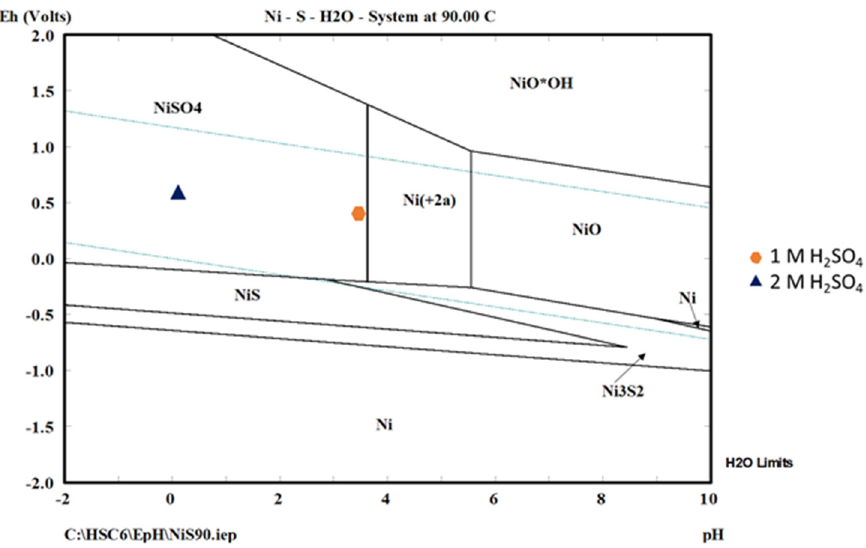
Figure 7. Pourbaix diagram for the Ni–S–H 2 O system at [Ni] = 0.017 M, 90 °C, and 0.55 MPa.